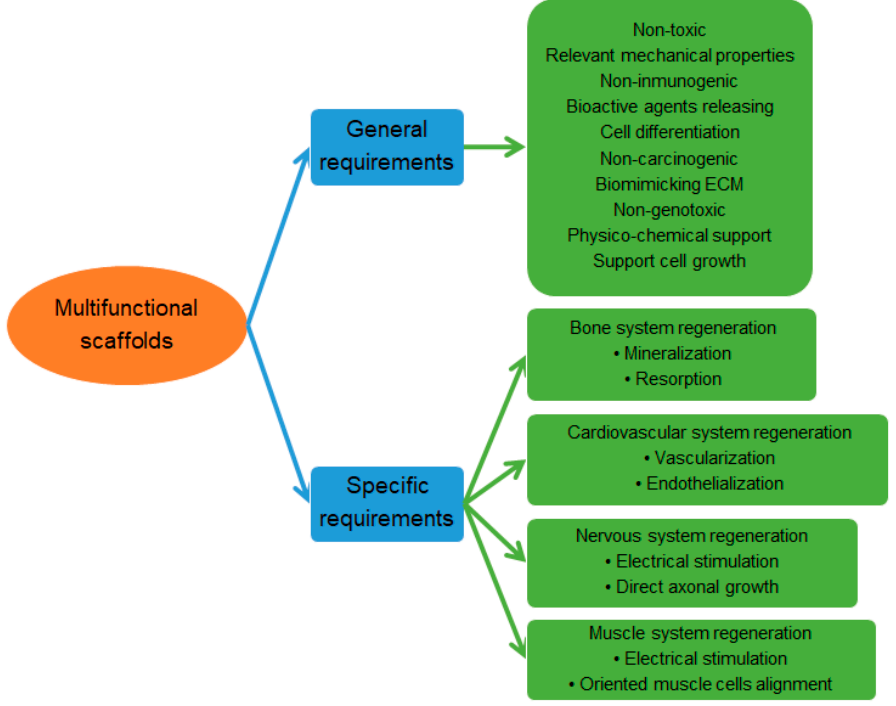
Figure 7. Scheme indicating the main requirements of bioscaffolds and their potential interest for